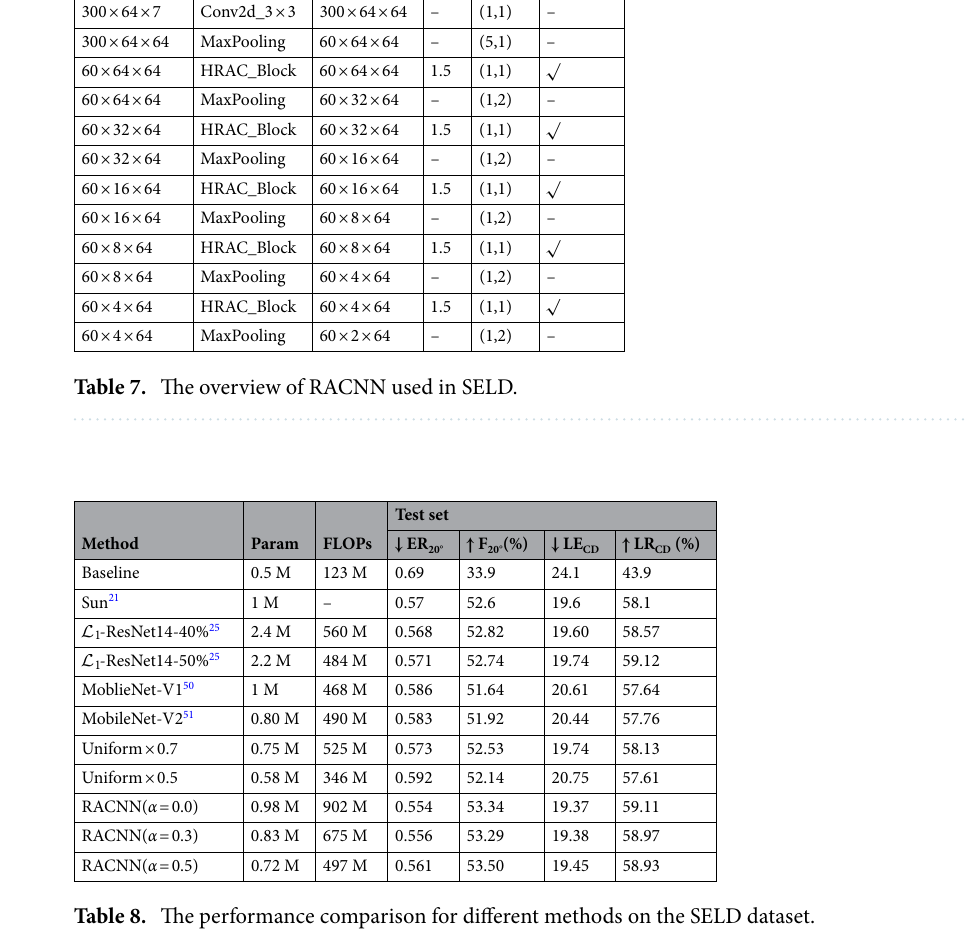
Table 8. The performance comparison for different methods on the SELD dataset.